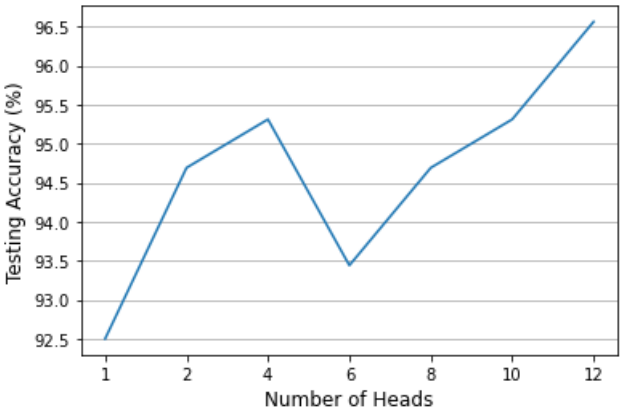
Figure 8. The influence of the number of multi-headed self-attention heads.